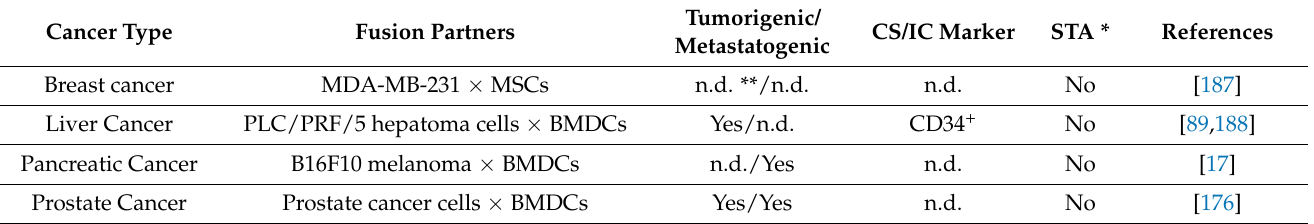
Table 3. In vivo cell–cell-fusion-derived tumor hybrids with prospective CS/IC characteristics. Cancer